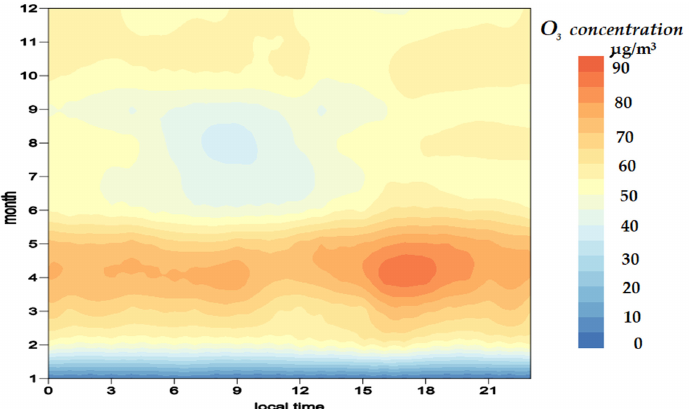
Figure 6. Seasonal and diurnal dynamics of the ground-level ozone on the shore of Lake Baikal, Listvyanka station, 2021.